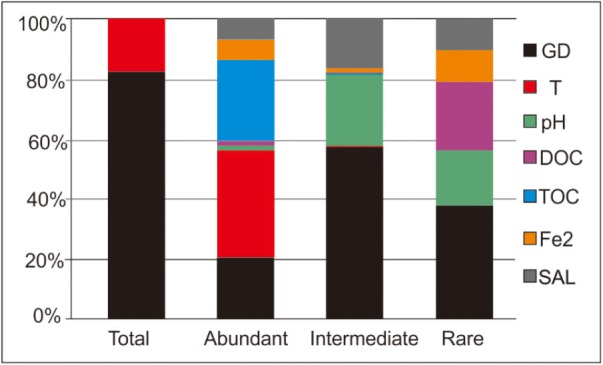
ABT analysis showing the relative influence of individual environmental factors and geographic distance on shaping of microbial communities of the total, abundant, intermediate, and rare biospheres (SAL, salinity; DOC, dissolved organic carbon; TOC, total organic carbon; GD, geographic distance; Fe2, Fe2+).